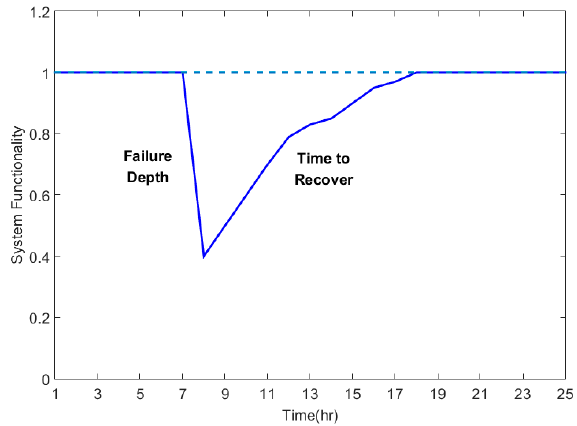
Figure 8. Conceptual illustration of resilience.